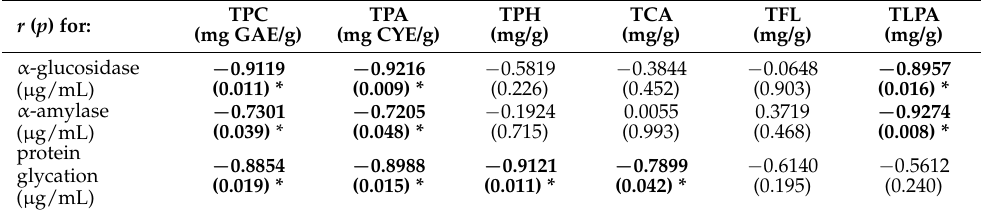
Table 4. Correlation coefficients ( r ) and probability ( p ) of the linear relationships between phenolic con- tents of Cotoneaster leaf and fruit extracts and their activity parameters—influence on α -glucosidase, α -amylase inhibition, and AGE